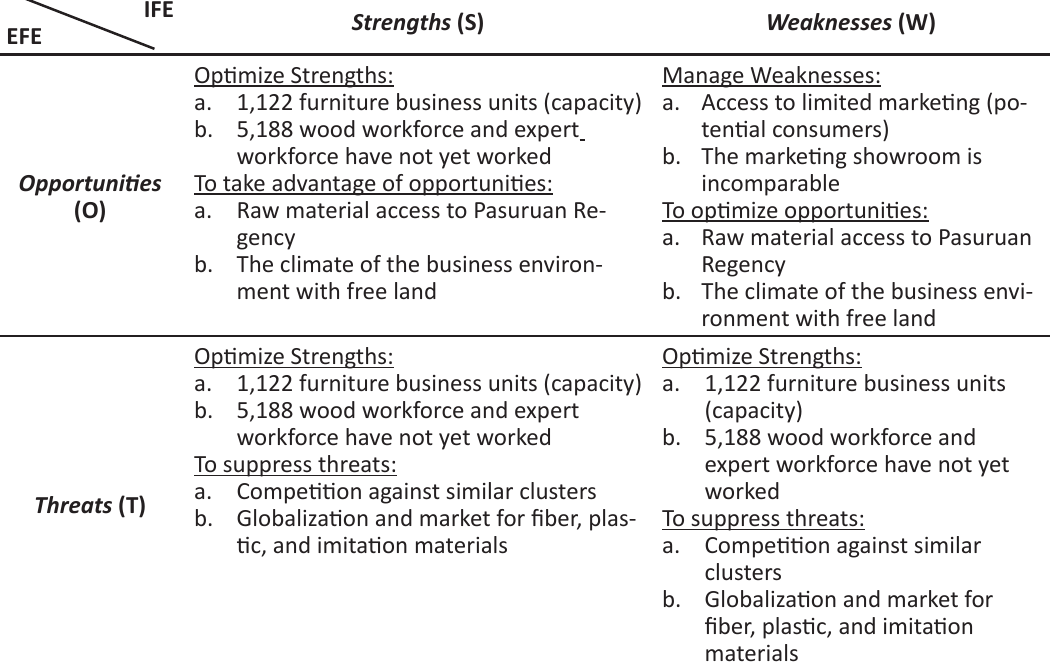
Tabel 5: SWOT Matrix of Furniture SME Cluster in Pasuruan